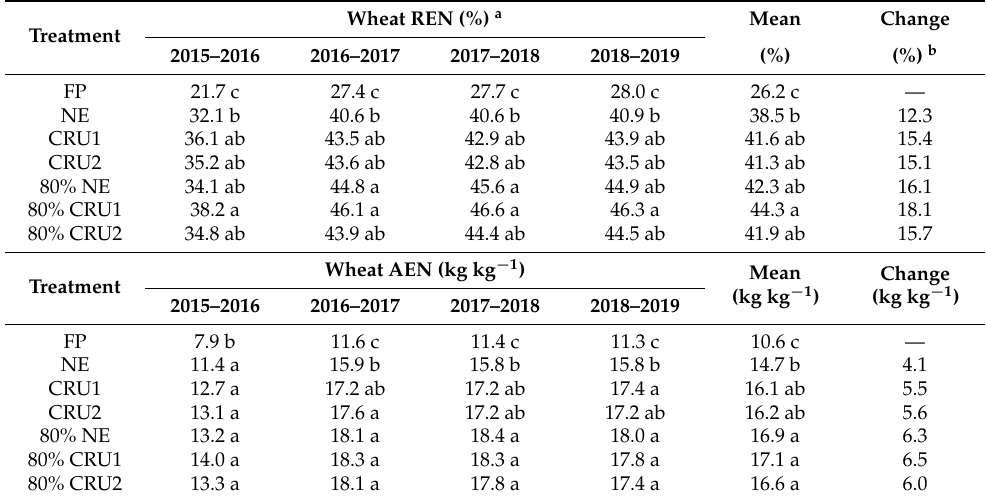
Table 3. Nitrogen use efficiencies of wheat in different fertilizer treatments in four growing seasons of a wheat–maize rotation from June 2015 to June 2019 in north-central China.